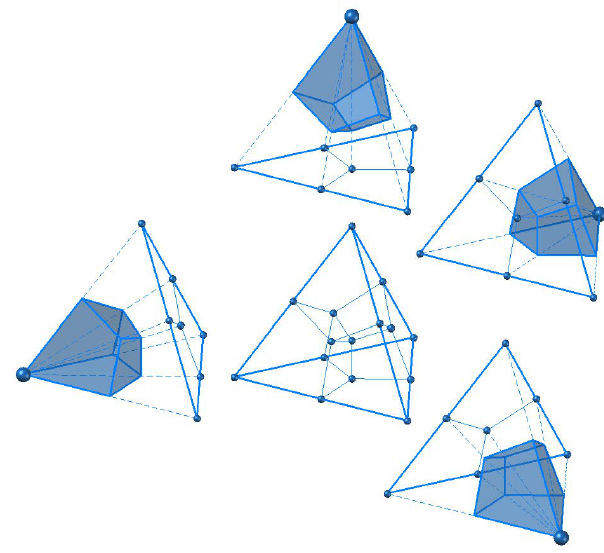
Figure 32: Vertex-centred central projection of a tesseract: detail of the projection of 4 of 8 cubic